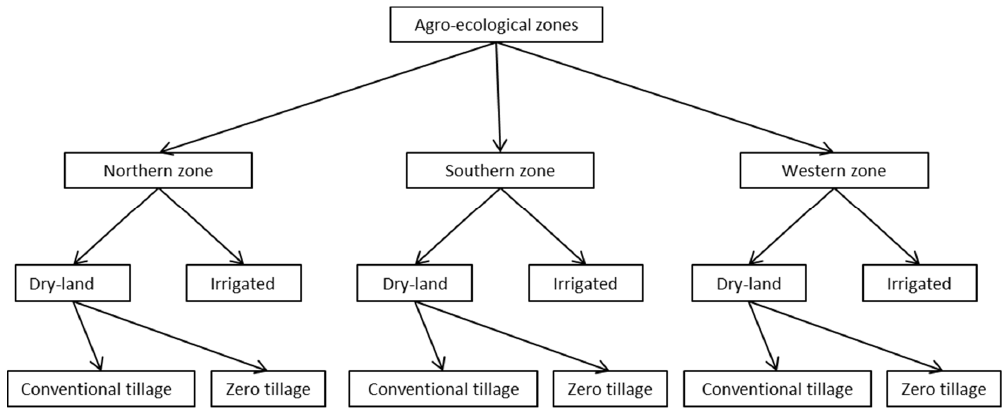
Figure 1. Showing different farming practices in the three agro ‐ ecological regions in Australia.